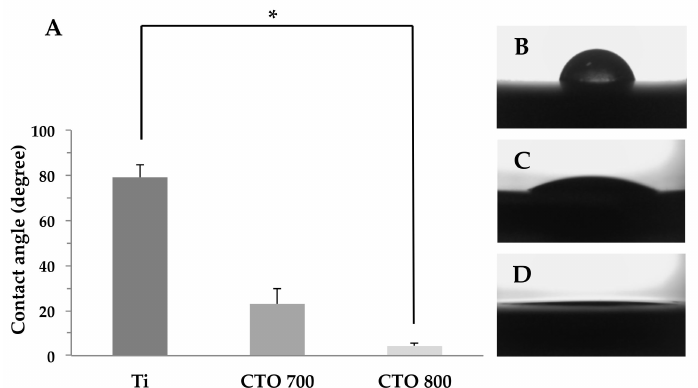
Figure 4. Hydrophilicity of Ti, CTO 700, and CTO 800. ( A ) Mean contact angle of 1 µ L H 2 O onto the substrate surface. Data are mean ± standard deviation. ( B – D ) typical photographic images of H 2 O droplets pipetted onto the specimen. ( B ): Ti; ( C ): CTO 700; ( D ): CTO 800.